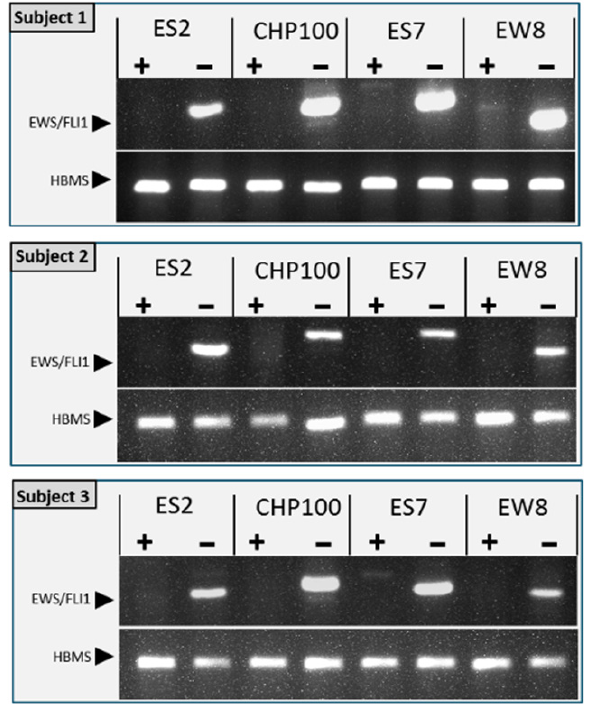
Figure 5. Detection of the ES specific EWS-FLI1 fusion transcript in purged ovarian cortex tissue. Ovarian cortex tissue fragments from three individuals with tumor foci of cell lines ES2, CHP-100, ES7 or EW8 was cut into two equal parts. One part was treated for 24 h with 50 µ M EVE, the